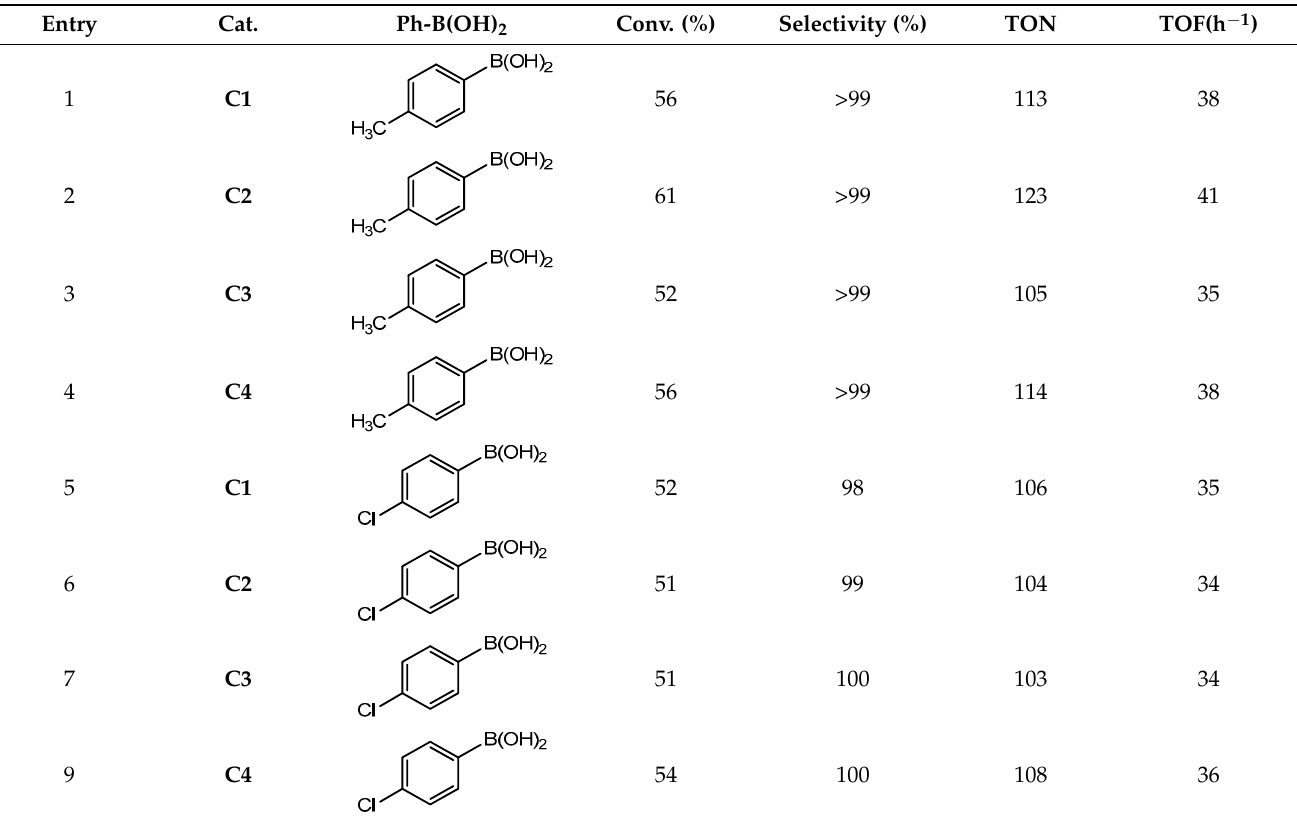
Figure 22. Suzuki ‐ Miyaura coupling of bromobenzene with substituted phenylboronic acid under optimum conditions. ta ‐ Table 10. Results obtained from Suzuki ‐ Miyaura coupling of bromobenzene with substituted phenylboronic acid under optimum conditions. optimum conditions. Table 10. Results obtained from Suzuki-Miyaura coupling of bromobenzene with substituted phenylboronic acid under Cat. Table 10. Results obtained from Suzuki ‐ Miyaura coupling of bromobenzene with substituted phenylboronic acid under optimum conditions. Table 10. Results obtained from Suzuki ‐ Miyaura coupling of bromobenzene with substituted phenylboronic acid under optimum conditions. optimum conditions. optimum conditions. optimum conditions. Cat. Cat. Table 10. Results obtained from Suzuki ‐ Miyaura coupling of bromobenzene with substituted phenylboronic acid under Table 10. Results obtained from Suzuki ‐ Miyaura coupling of bromobenzene with substituted phenylboronic acid under optimum conditions. optimum conditions. optimum conditions. optimum conditions. Cat. Table 10. Results obtained from Suzuki ‐ Miyaura coupling of bromobenzene with substituted phenylboronic acid under Table 10. Results obtained from Suzuki ‐ Miyaura coupling of bromobenzene with substituted phenylboronic acid under optimum conditions. optimum conditions. Cat.